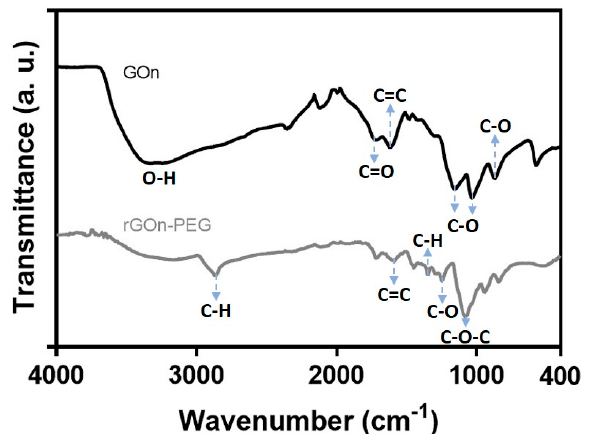
Figure 3. FTIR spectra of GOn and rGOn-PEG. Infrared spectra of GOn (black line) and rGOn-PEG (grey line) describe the contribution of several surface functionalities.